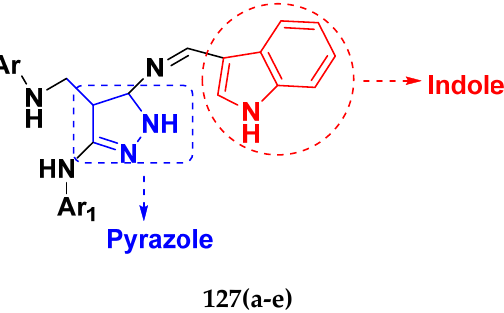
Figure 120. Structure of pyrazole-based indole derivatives 127 ( a – e ). Table 107. In vitro cytotoxic activities of pyrazole-based indole hybrid compounds 127 ( a – e ). Compound No.